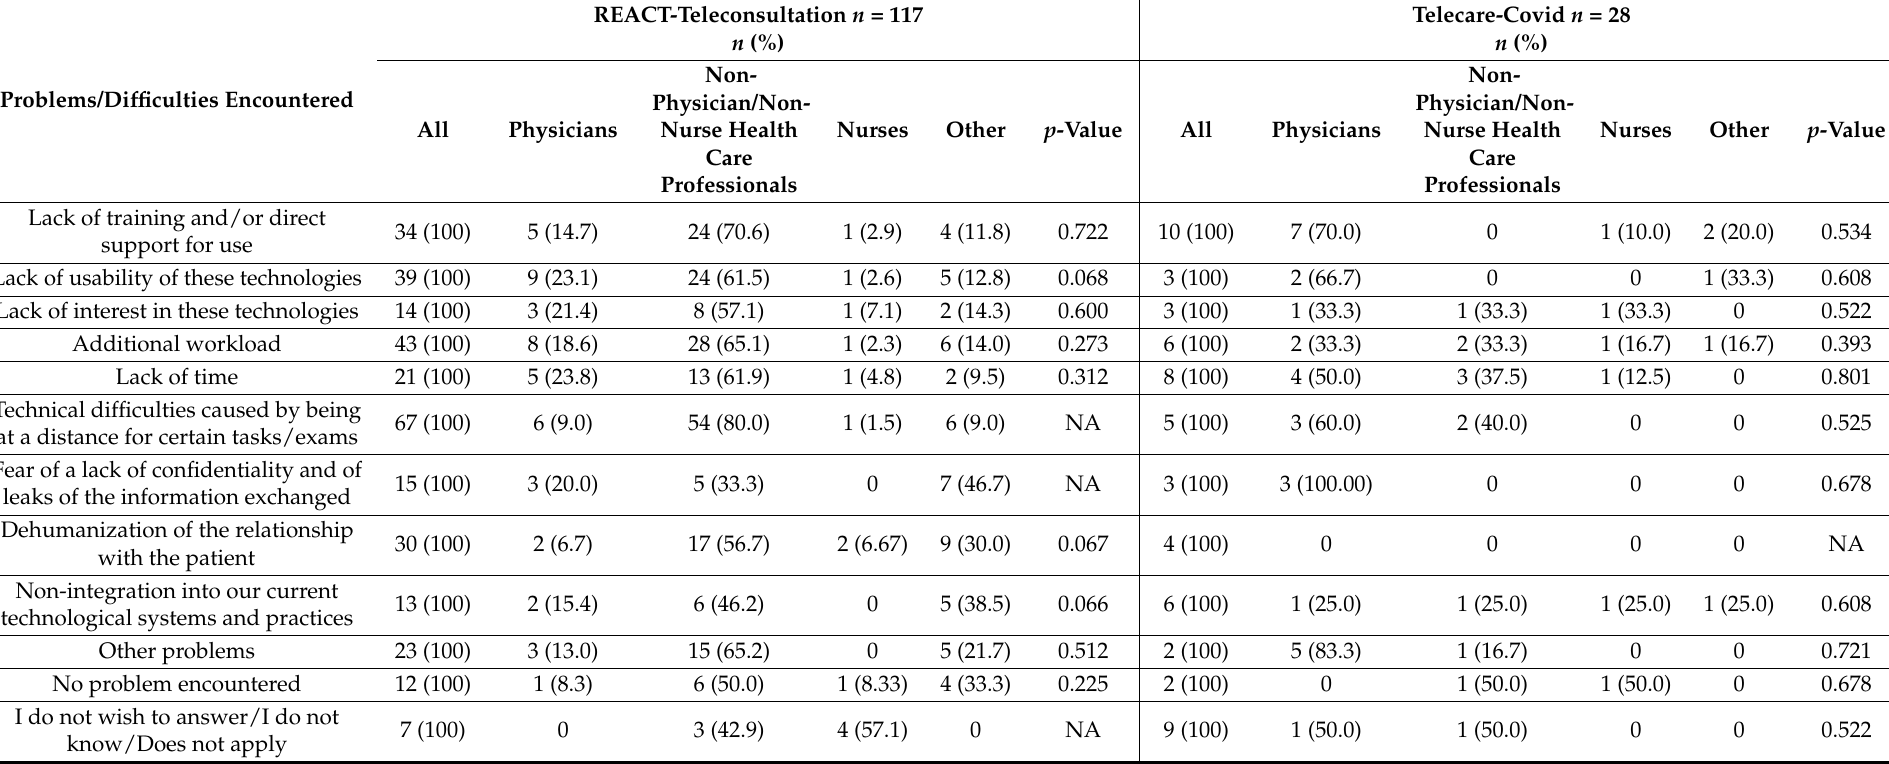
Table 4. Perceptions of participants who evaluated the role and relevance (usefulness, advantages, and limitations) of